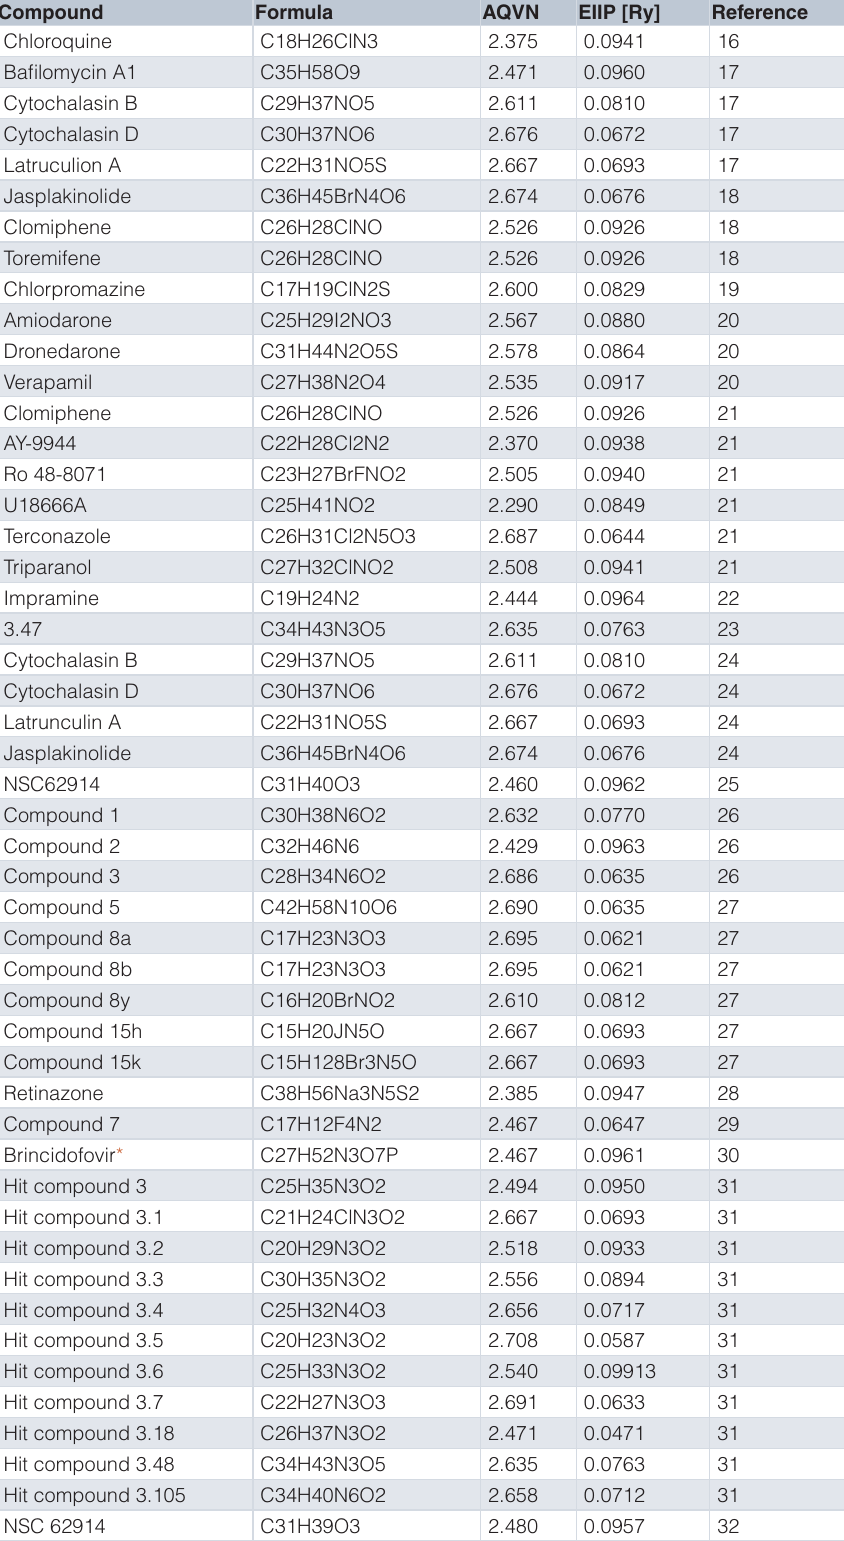
Table 1. Small-molecule entry inhibitors for Ebola